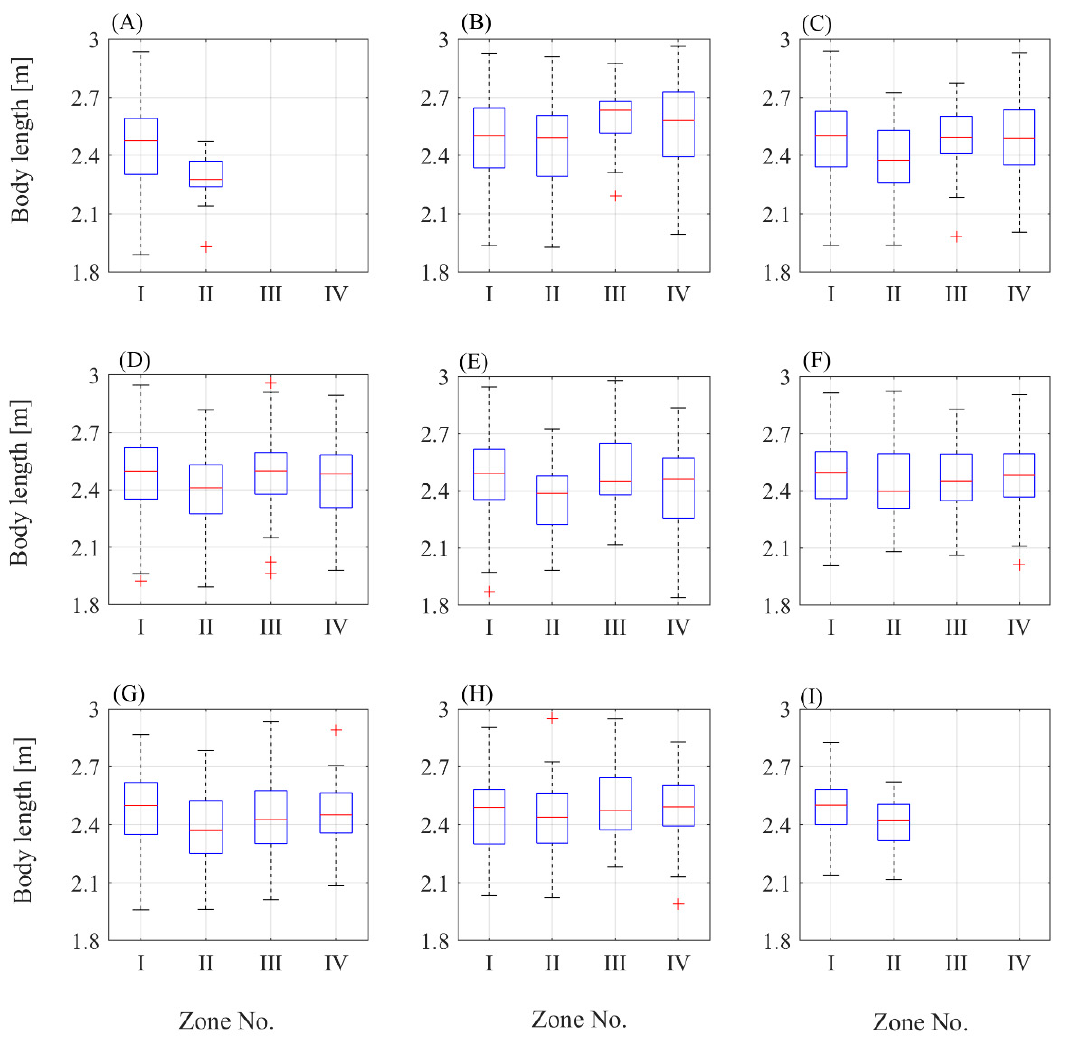
Figure 10. Body length of females on di ff erent days: ( A ) October 13; ( B ) October 15; ( C ) October 19; Figure 10. Body length of females on different days: ( A ) October 13; ( B ) October 15; ( C ) October 19; ( D ) October 24; ( E ) October 27; ( F ) November 1; ( G ) November 4; ( H ) November 7; and ( I ) November 16. ( D ) October 24; ( E ) October 27; ( F ) November 1; ( G ) November 4; ( H ) November 7; and ( I ) November The line in the middle of the box indicates the median, the box edges represent the first and third quantiles, thewhiskers correspond tothe minimum and maximumvalues, and crossesrepresentoutliers. 16. The line in the middle of the box indicates the median, the box edges represent the first and third quantiles, the whiskers correspond to the minimum and maximum values, and crosses represent Finally, an additional advantage of obtaining such observations and measurements of female outliers. southern elephant seals using drones is the ability to assess their age. Several expressions are available in the literature that combine the length and age of females [41]. However, based on one of the simplest, BL = 1.67*age 0.20 , we can determine the relationship between body length (BL) and age. Figure 11 shows the age distribution of females at Patelnia Point (Figure 11A) and the division of the number of individuals into zones based on age (Figure 11B). On this basis, we concluded that the average age of females for October 27 was 7.58 ± 3.04 years. Unfortunately, the other available models have asymptotic limitations; for example, when using BL = 2.57exp( − exp( − 0.65(age + 0.23))) [41], the ages of females whose lengths exceed 2.57 m cannot be determined. Nevertheless, there is still significant potential in such estimation